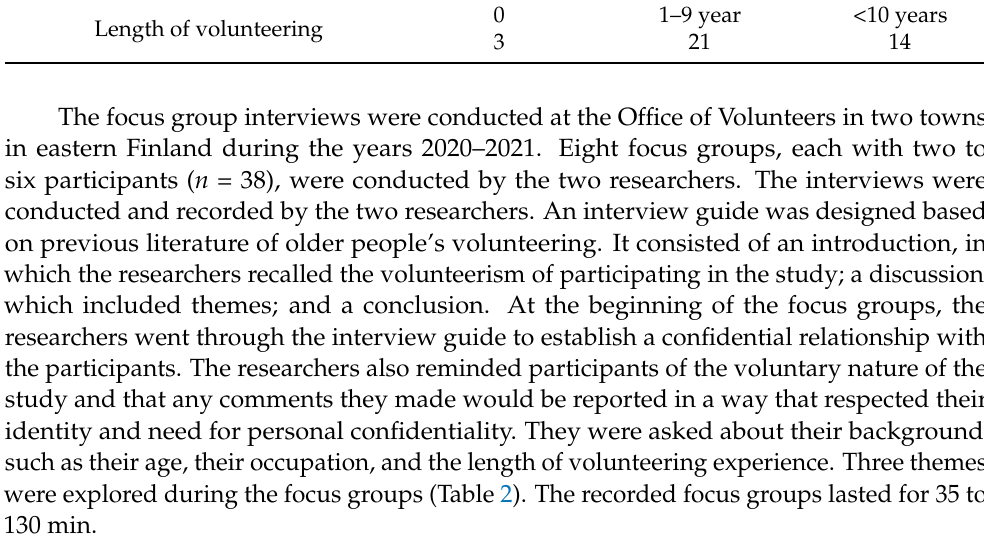
Table 2. An interview guide for the focus groups.